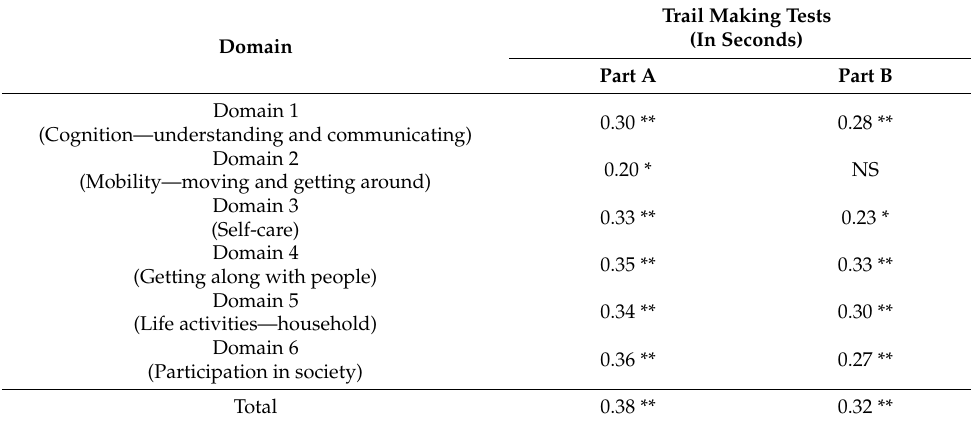
Table 4. Correlations with trail making test